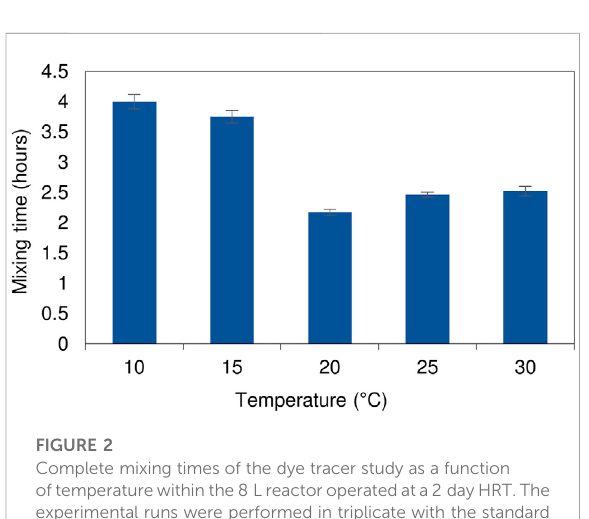
FIGURE 2 Complete mixing times of the dye tracer study as a function oftemperaturewithin the8 Lreactoroperatedata2 dayHRT.The experimental runs were performed in triplicate with the standard deviation shown by the error